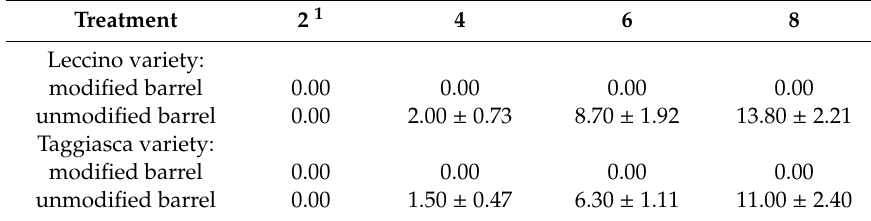
Table 2. Yeast film contamination (%) of brines stored in modified and unmodified industrial barrels during fermentation.